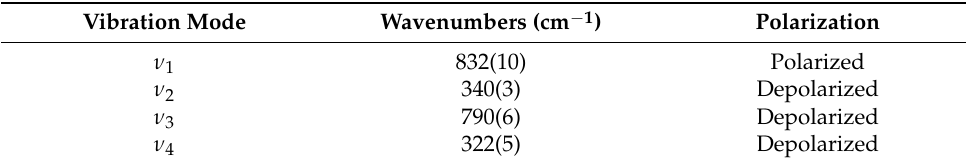
Table 2. Raman peaks of K 2 FeO 4 in aqueous solution (pH~13.6)